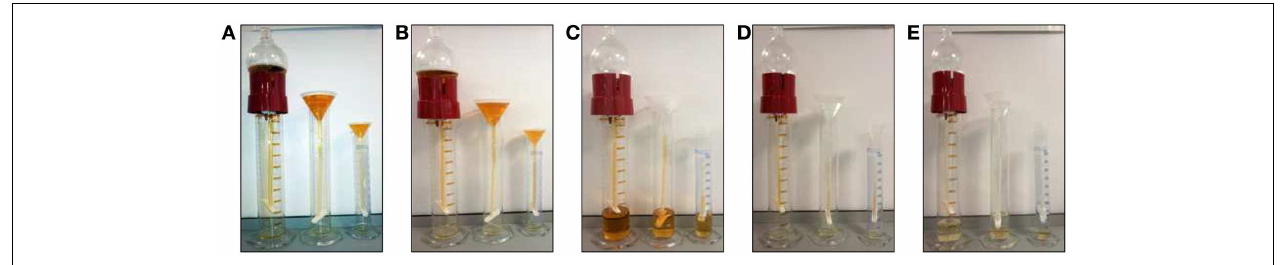
of the cylinder (B) .When urine is concentrated up to 7–8ml (C) the funnel is re-filled with milliQ water (~200ml equivalent to 25 volumes of concentrated urine), which flushes away all analytes left inside the tube (D) .This dialysis step is kept going until the solution is completely clear from yellow pigments (as internal natural control) and concentrated to a desired final volume (E) .The whole process has been named hydrostatic dialysis. Finally, it is possible to observe the diffusion of urine from the tube and precipitation at the bottom of the cylinder (E)